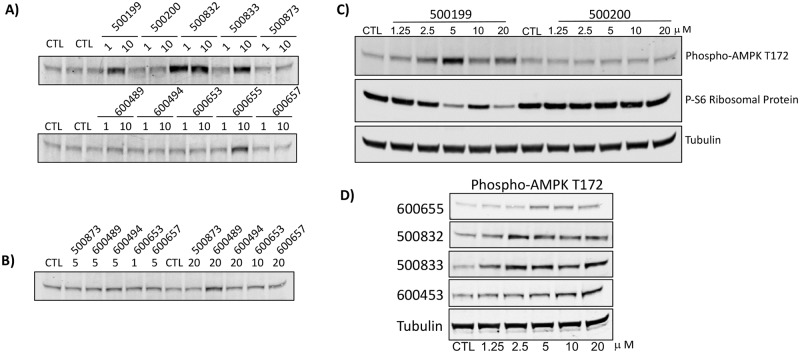
Validation of AMPK pathway activation by phenylbenzamide derivatives in HepG2 cells.A) Cells were seeded at 10,000 cells per well 24 hours prior to treating cells with indicated concentration of compound or DMSO (CTL) for 4 hours. 16μL of cell lysate was incubated with HTRF phospho-AMPK detection reagents and fluorescence emission read at 665nm and 620nm using a PHERAstar platereader. The mean and standard deviation of the HTRF Ratio from three replicate wells is shown. The unstimulated (DMSO) and positive controls lysates are shown in green and red respectively.